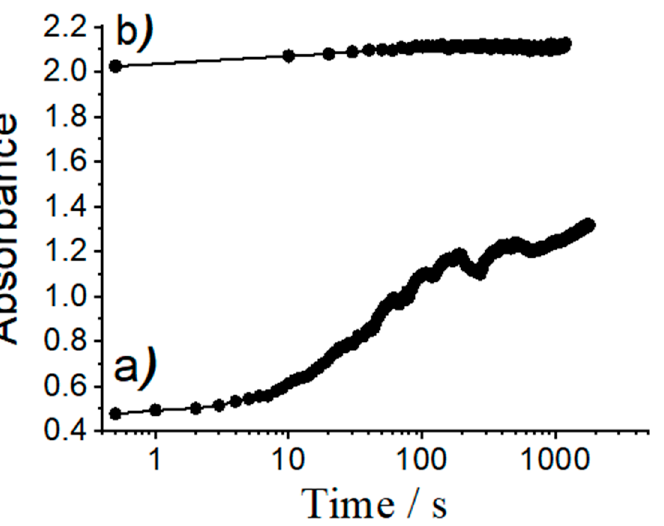
Figure 8. Absorbance values of dye released from solids ( a ) ARhB and ( b ) ASRB vs. time. Experi- ments were carried out by suspending ca. 0.3 mg of the corresponding materials in 3 mL of PBS in a quartz cuvette and monitoring dye release by measuring the absorbance values at 564 nm for SRB and at 555 nm for RhB vs. time.